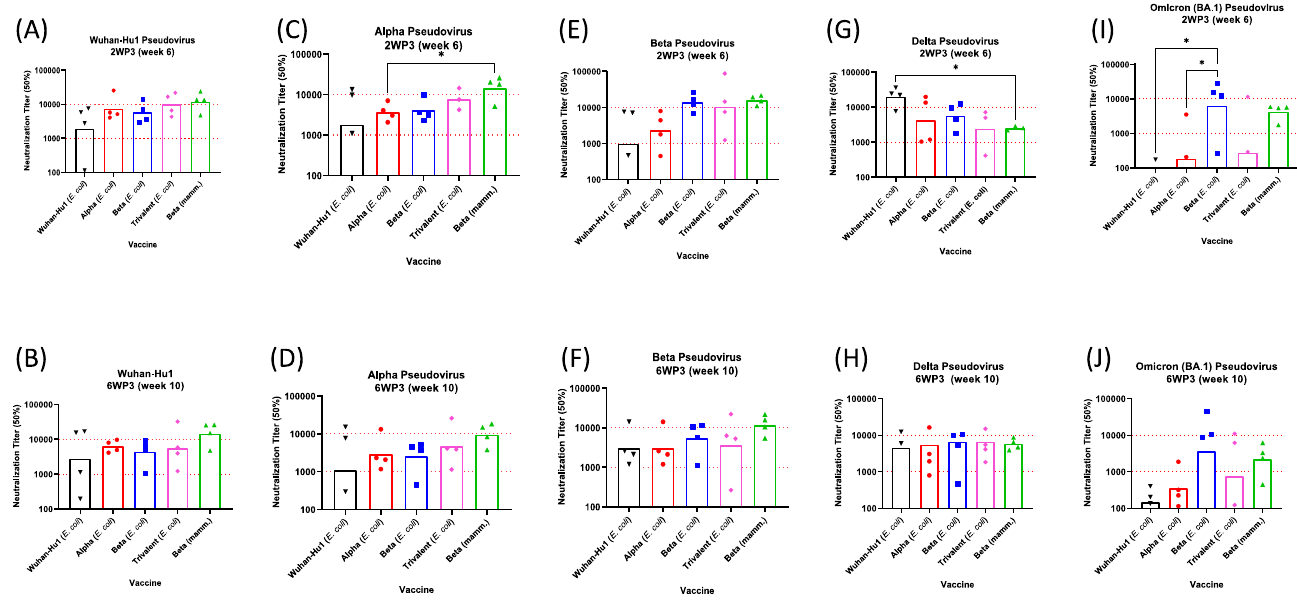
Figure 5. Pseudovirus neutralization titers induced by vaccination with recombinant RBDs. Indi- vidual mouse ID 50 titers are indicated for each vaccine group ( E. coli Wuhan-Hu1, black inverted triangles; E. coli Alpha, red circles; E. coli Beta, blue squares; trivalent, pink diamonds; mammalian Beta, green triangles), while geometric mean titers are indicated by each bar. Mouse sera at week 6 (2WP3, top panels) and week 10 (6WP3, bottom panels) were tested in pseudovirus neutralization assays against Wuhan-Hu1 ( A , B ), Alpha ( C , D ), Beta ( E , F ), Delta ( G , H ), and Omicron BA.1 ( I , J ) pseu- doviruses. Pre-immune sera showed ID 50 titers <40 across all pseudoviruses (not plotted). Significant p -values between groups are shown with * ( p < 0.05).